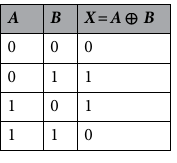
Table 1. Truth table of an XOR